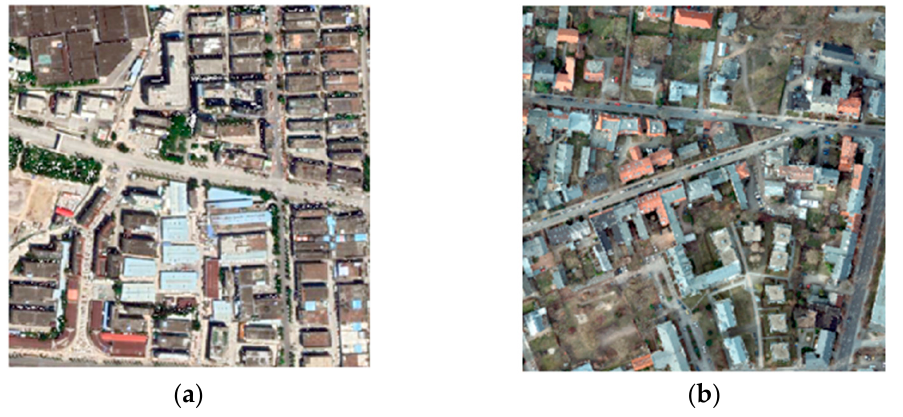
Figure 2. Two high-resolution remote sensing images for cross-domain testing. ( a ) The first image from Google Images at Shenzhen, China, with 500 × 500 pixels and a spatial resolution of 1 m for urban area. ( b ) The third image from ISPRS semantic segmentation dataset at Postdam, Germany, with 6000 × 6000 pixels and a spatial resolution of 0.05 m for suburban area.